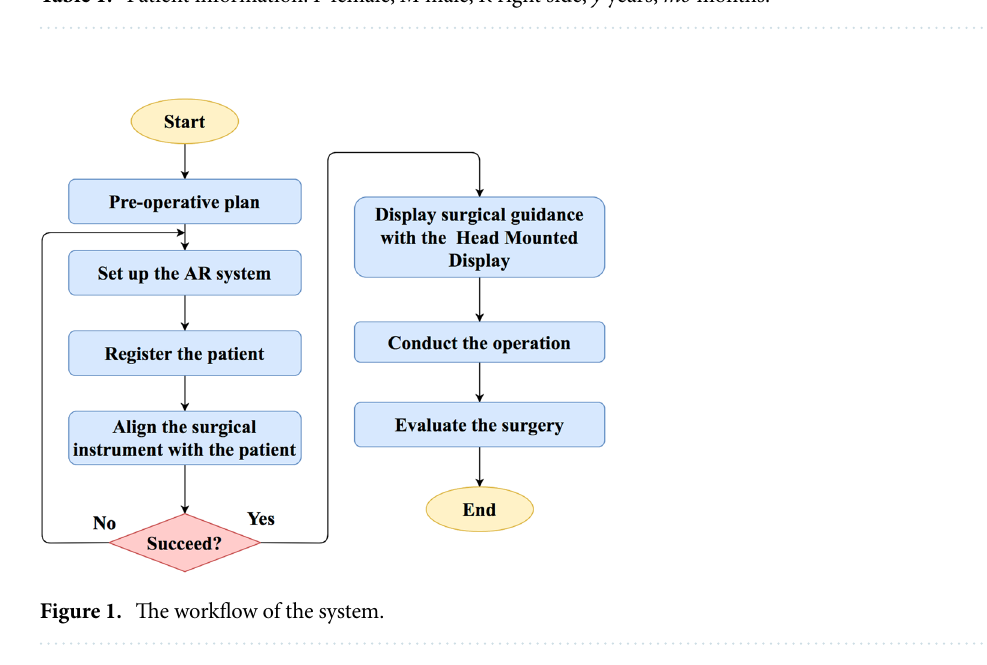
Table 1. Patient information. F female, M male, R right side, y years, mo months.